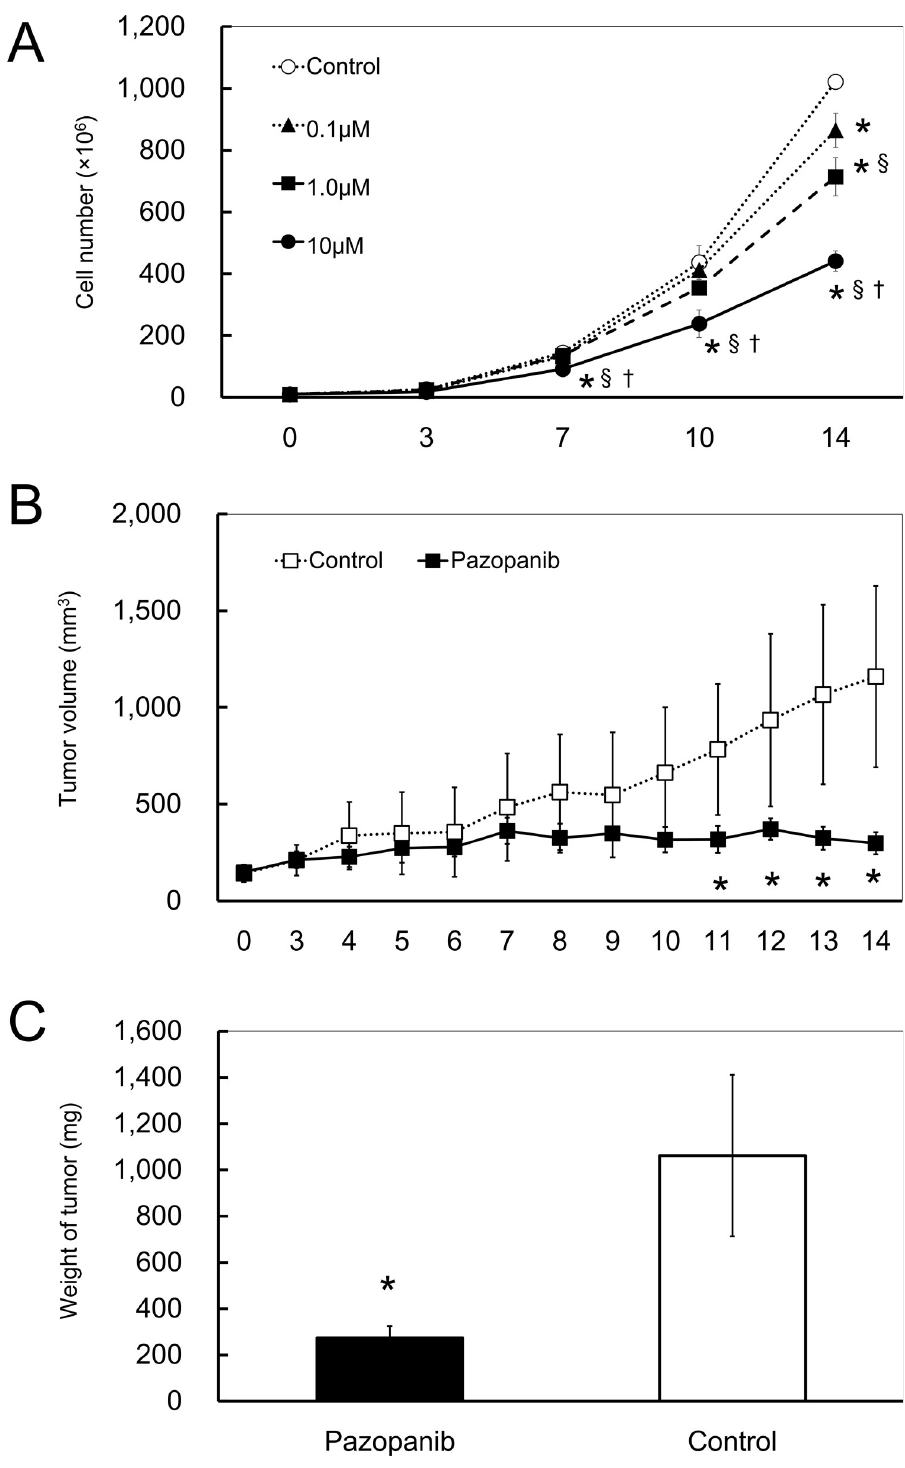
Fig 7. Suppressive effect of pazopanib on the proliferation of PIS-1 cells. (A) Effect of pazopanib, which is a multikinase inhibitor, on the proliferation of PIS-1 cells 14 days after treatment. � p < 0.05, vs control; § p < 0.05, vs 0.1 μ M; † p < 0.05, vs 1.0 μ M group. (B) Tumor volumes of mice with 14-day administration of pazopanib compared to those of the control. � p < 0.05, vs control of each day. (C) The mean weights of subcutaneous tumors resected from mice of the pazopanib group compared to those of the control group. Error bars show standard deviation. � p < 0.05, vs control. https://doi.org/10.1371/journal.pone.0214654.g007 PLOS ONE | https://doi.org/10.1371/journal.pone.0214654 March 29,